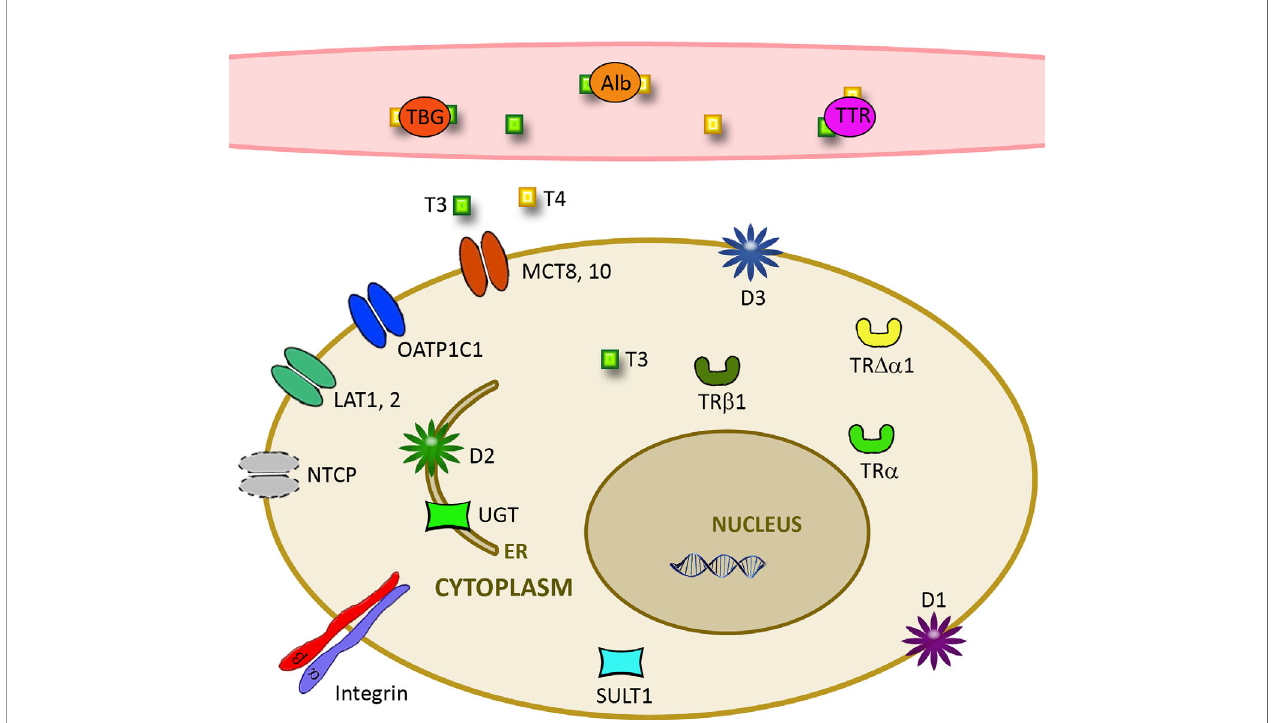
FIGURE 1 | Important parameters for cellular effects of thyroid hormones. Free TH levels are in fl uenced by the amount of distribution proteins such as albumin (Alb), thyroxine-binding globulin (TBG), and transthyretin (TTR). Cellular uptake is determined by expression of transporters like L-amino acid transporter (LAT), monocarboxylate transporter (MCT), Na+/taurocholate cotransporting polypeptide (NTCP), and organic anion transporting polypeptide (OATP). Deiodinases D1-3 together with Sulfotransferases (SULT1) and UDP-glucuronosyltransferases (UGT) determine action on the cellular level. Cellular effects are further in fl uenced by the level of a v b 3 integrin and truncated and nuclear receptors TR a and TR b